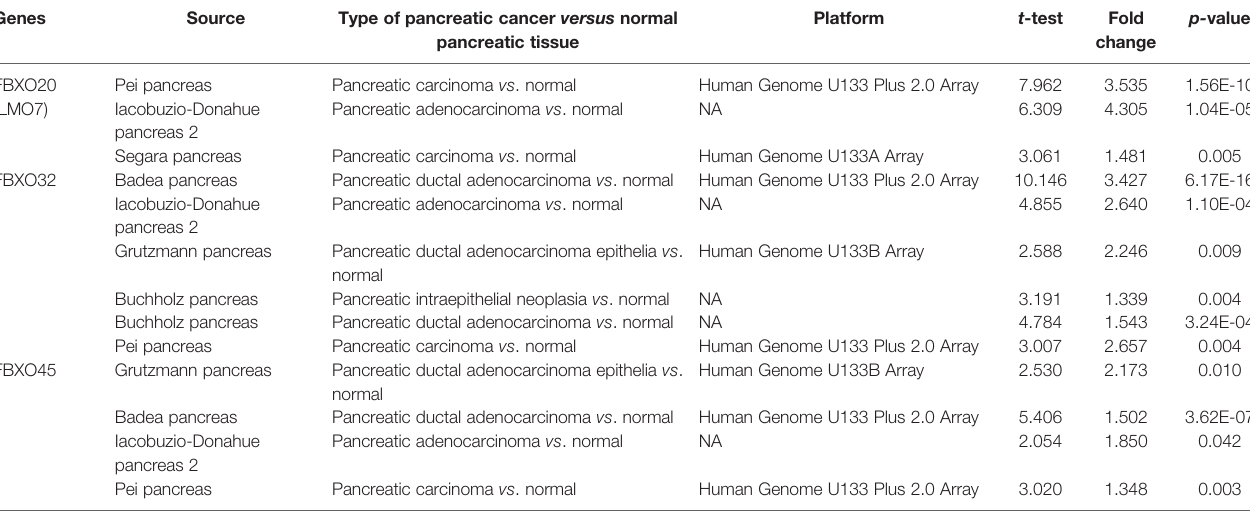
TABLE 1 | The signi fi cant changes of FBXO transcription levels between PDAC tissues and normal pancreatic tissues (Oncomine). Genes Source Type of pancreatic cancer versus normal Platform t pancreatic tissue